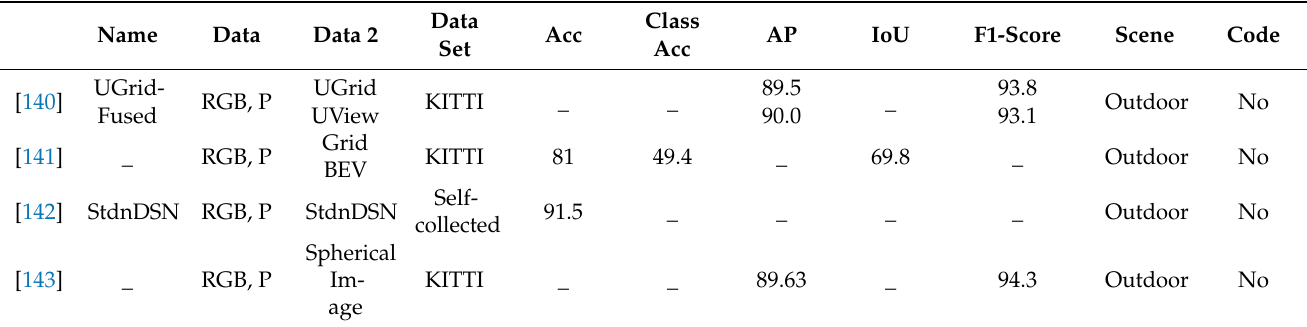
Table 6. Comparative summary of segmentation methods using data-based fusion strategy (P: point cloud; Data 2: intermediate data).